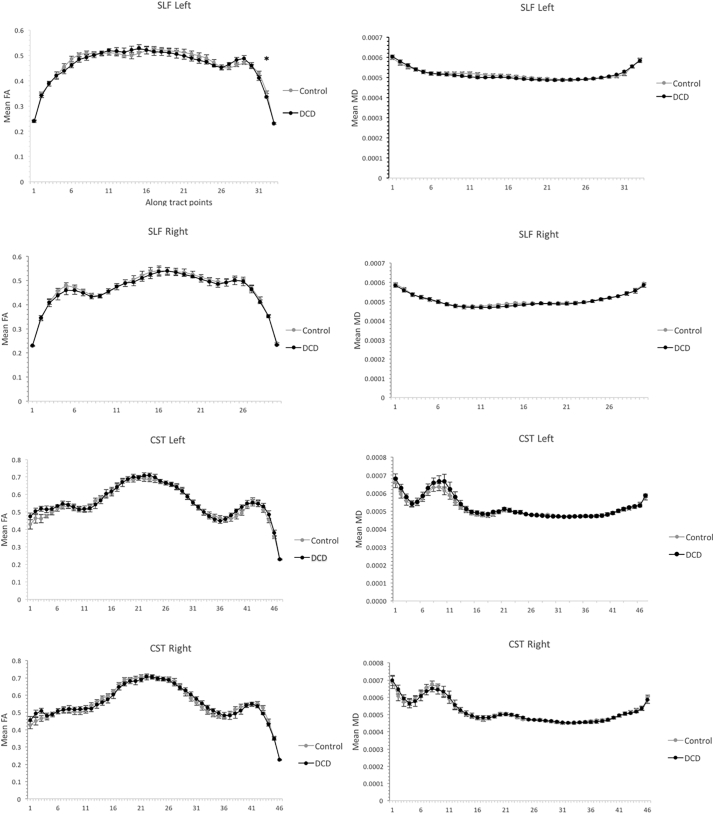
Along tract values for DTI modelled SLF and CST tracts, including mean FA and MD. Error bars reflect standard error. * Represents points where group differences reached statistical significance at p <.05 uncorrected. No comparisons survived FDR correction. NOTE: DTI- Diffusion tensor imaging; SLF, superior longitudinal fasciculus; CST, corticospinal tract; FA, fractional anisotropy; MD, Mean Diffusivity.